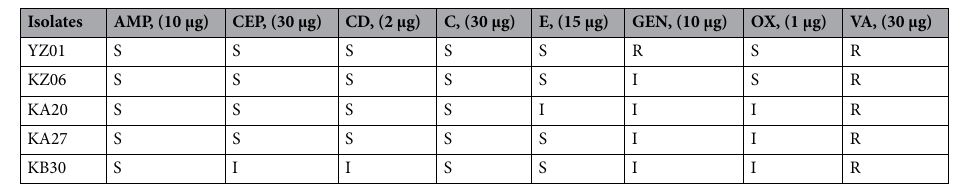
Table 3. Antibiotic susceptibility pattern of lactic acid bacteria strains. AMP Ampicillin, CEP Cephalothin, CD Clindamycin, C Chloramphenicol, E Erythromycin, GEN Gentamicin, OX Oxacillin, VA Vancomycin, S Susceptible, I Intermediate, R Resistant. NB: Isolates LBH1066, 1073, 1074, 1148 (Data not available).